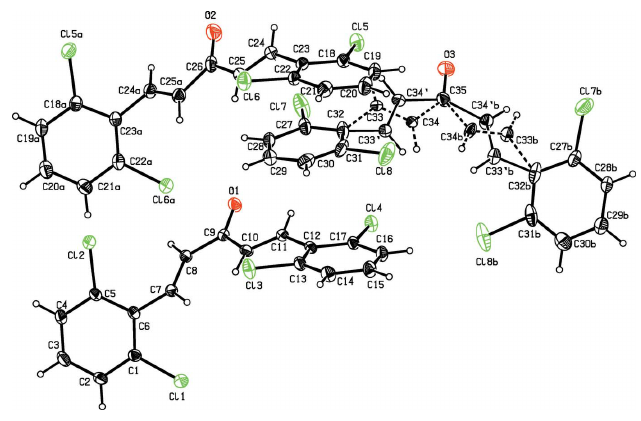
Figure 1 An ORTEP plot of the title compound with three molecules in the asymmetric unit, with displacement ellipsoids drawn at 20% probability level. Both disorder components are shown. [Symmetry codes: (a) (cid:5) x , 1 (cid:5) y , z ; (b) (cid:5) x + 1 , (cid:5) y + 3 , z .] 2 2